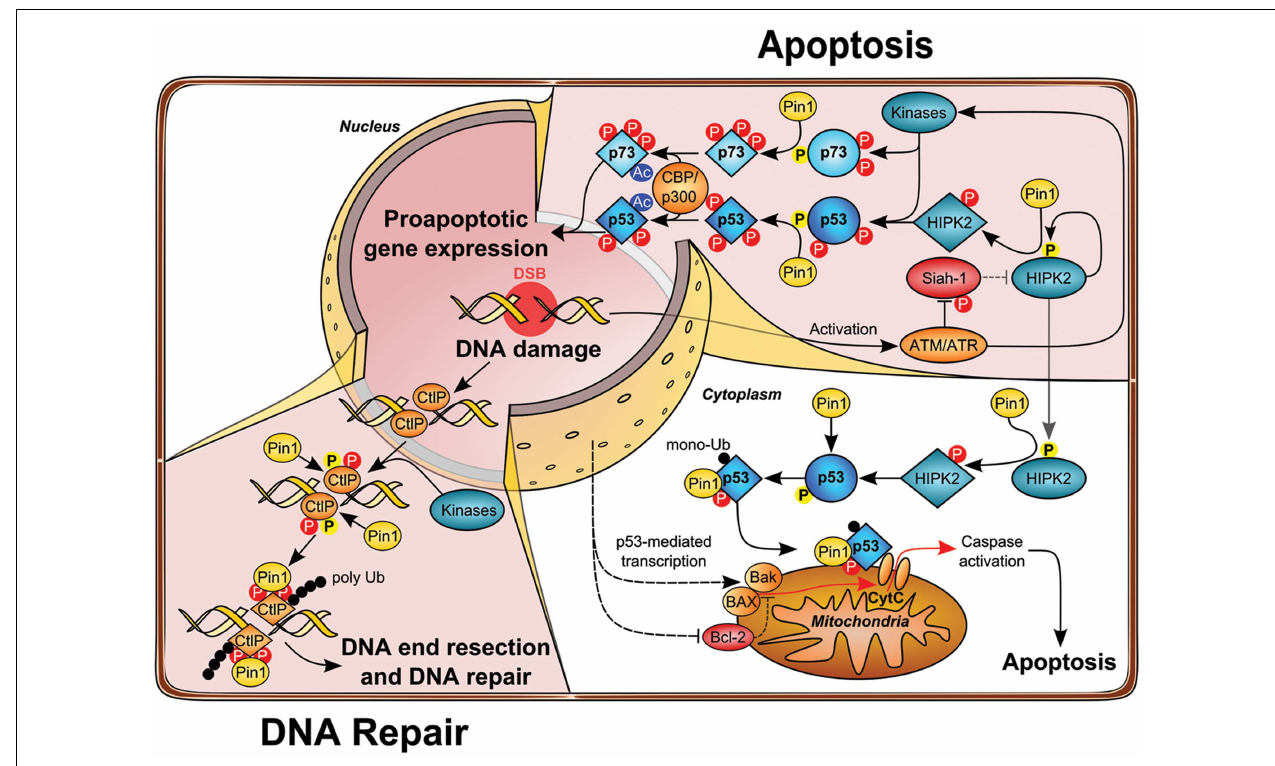
FIGURE 2 | Role of Pin1 in DNA damage-induced apoptosis and DNA repair pathways . Upon DNA damage ATM loosens the HIPK2–Siah1 complex by phosphorylation of Siah1, thereby allowing HIPK2 autophosphorylation. Phosphorylated HIPK2 recruits Pin1, which in